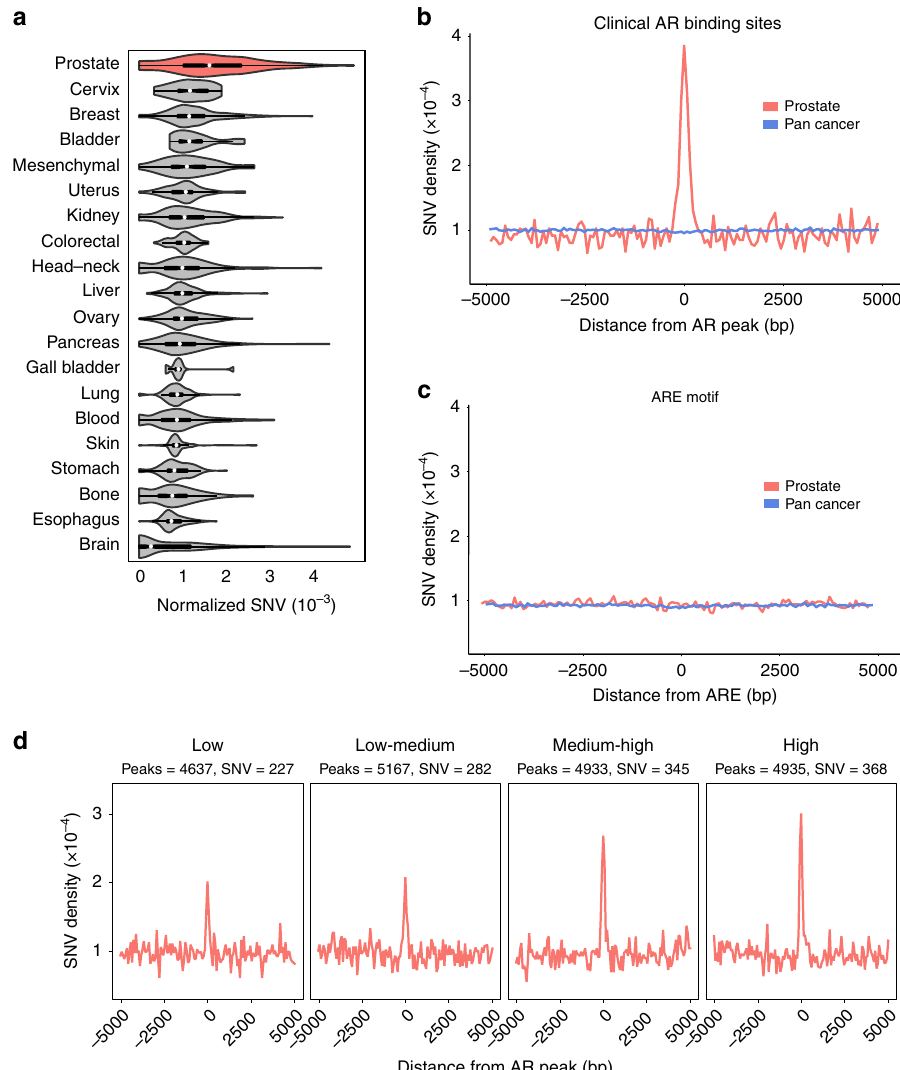
Fig. 2 ARBS have an increased rate of mutations only in PCa. a PCa (red) has the highest normalized SNV rate at clinical ARBS of all cancer types. b The mutational density ±5 kb at clinical ARBS was markedly increased in PCa (red) but not in all other cancers (blue). c A similar analysis was done at regions in the genome that had the canonical ARE motif but no AR binding. No increase in mutational rate was seen in either PCa (red) or other cancers (blue). d AR ChIPseq peaks were divided into quartiles based on peak height (low/low – medium/medium – high/high). A clear correlation was observed between peak height and increased SNVs at